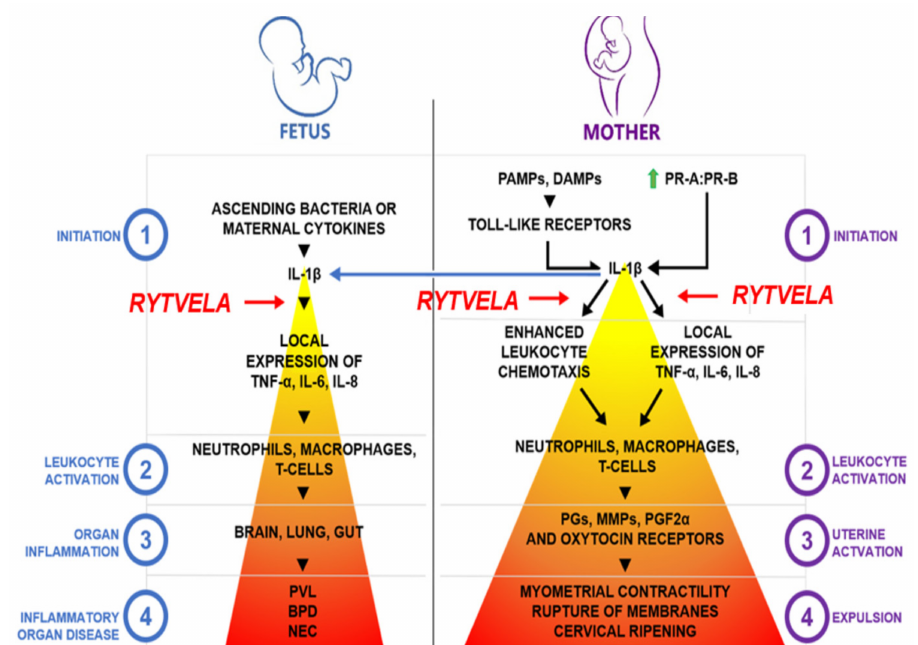
Figure 3. Conceptual model for the role of IL-1 β in preterm labor and fetal inflammation. This model illustrates that IL-1 β is the apex cytokine in the inflammatory cascade of preterm birth and fetal inflammatory injury, thereby presenting an attractive molecular target for drug discovery. PR-A/PR-B, P4 receptors A and B; PGs, prostaglandins; MMPs, matrix metalloproteinases; PGF 2 α , prostaglandin F 2 α ; PLV, periventricular leukomalacia; BPD, bronchopulmonary dysplasia; and NEC, necrotizing enterocolitis. Increasing color intensity represents increasing inflammatory response. The level where Rytvela acts is identified by red arrows. Courtesy of Han